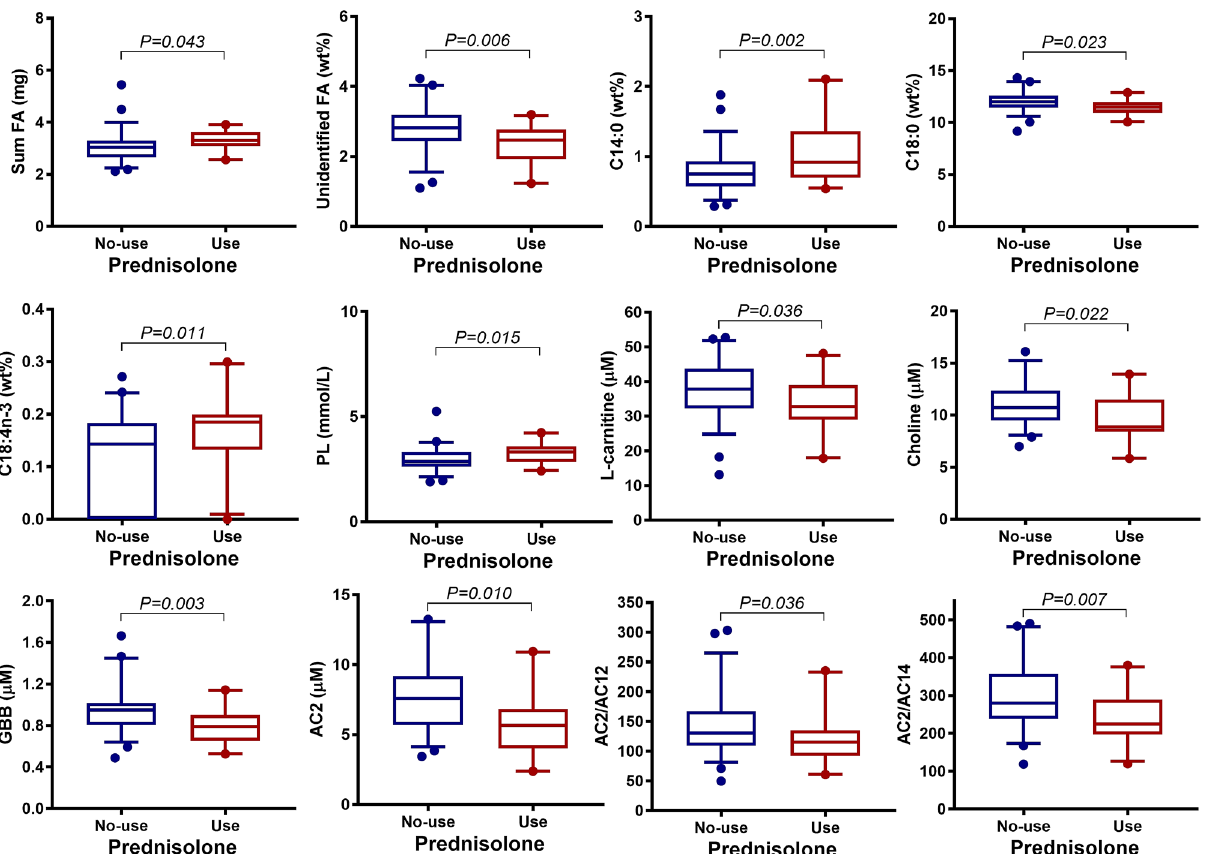
Figure 3. Association between whole blood FA, serum lipids, serum carnitine- and choline derivatives and prednisolone medication in RA patients (N = 78). Boxplots show FA, lipids, and carnitine- and choline derivatives significant associated with intake of prednisolone (no prednisolone, N = 57, coloured in blue; prednisolone medication, N = 21, coloured in red). P values are based on Student t-test. The boxplots show medians, the error bars indicate 5–95% confidence interval. The connectors show statistically significant differences, P < 0.05. P values are based on Student